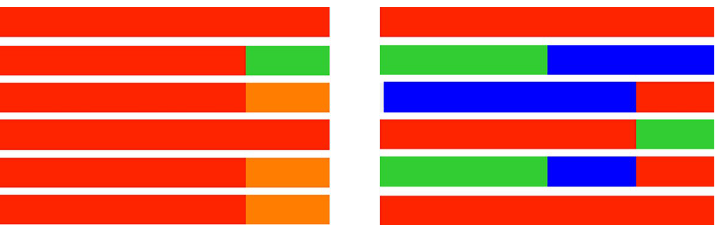
Fig 3. Aeromonas structure in S . pyrenaicus (left) and I . lusitanicum (right). Each line represents a sampled individual and shows the relative proportion of isolation (in %) of each Aeromonas species from the individual. Red– A . hydrophila , green– A . caviae , orange– A . veronii ; blue– A . media